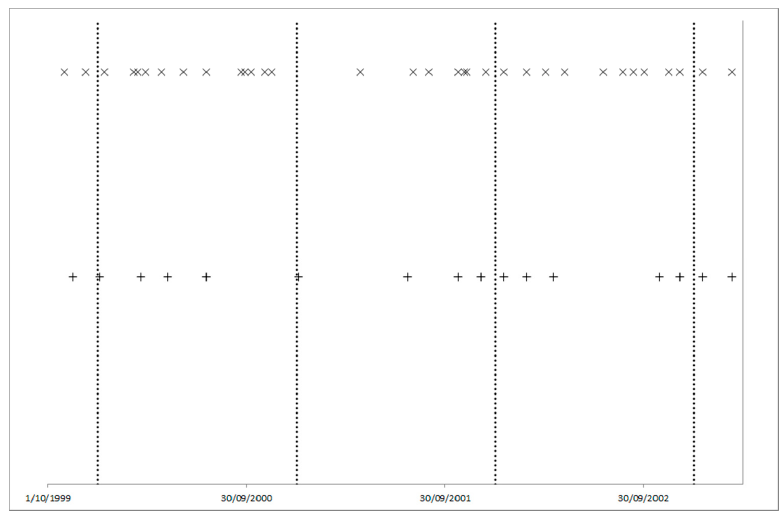
Figure 1. Harvest dates for each defoliation treatment at Burraja (Experiment 1). Lax = +, Severe = ×. Vertical dotted lines represent the start of each calendar year.